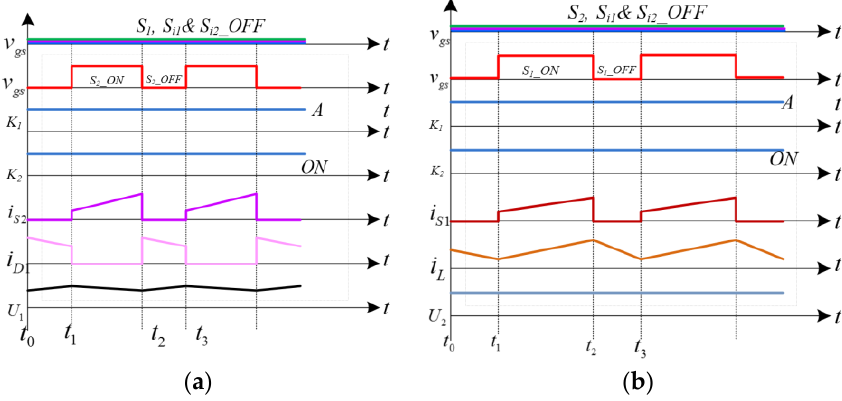
Figure 9. The key waveforms in non-isolated mode: ( a ) step-up mode; and ( b ) step-down mode.